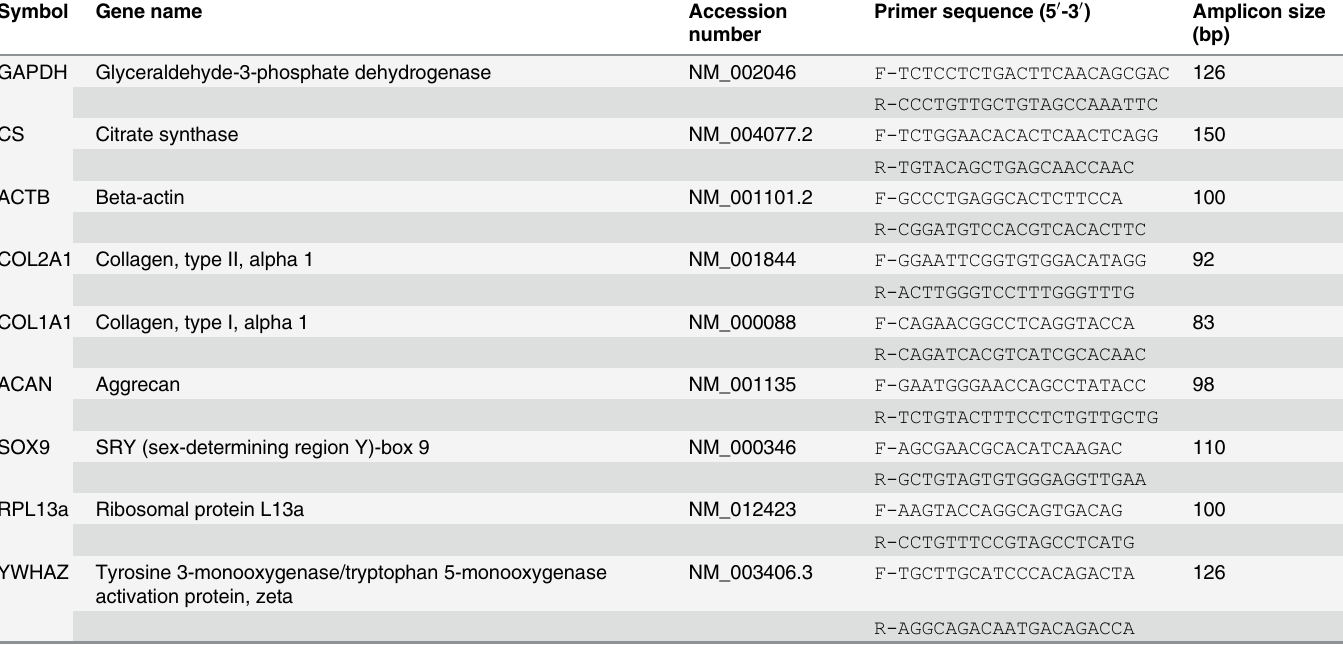
Table 1. Primer sequences for real-time